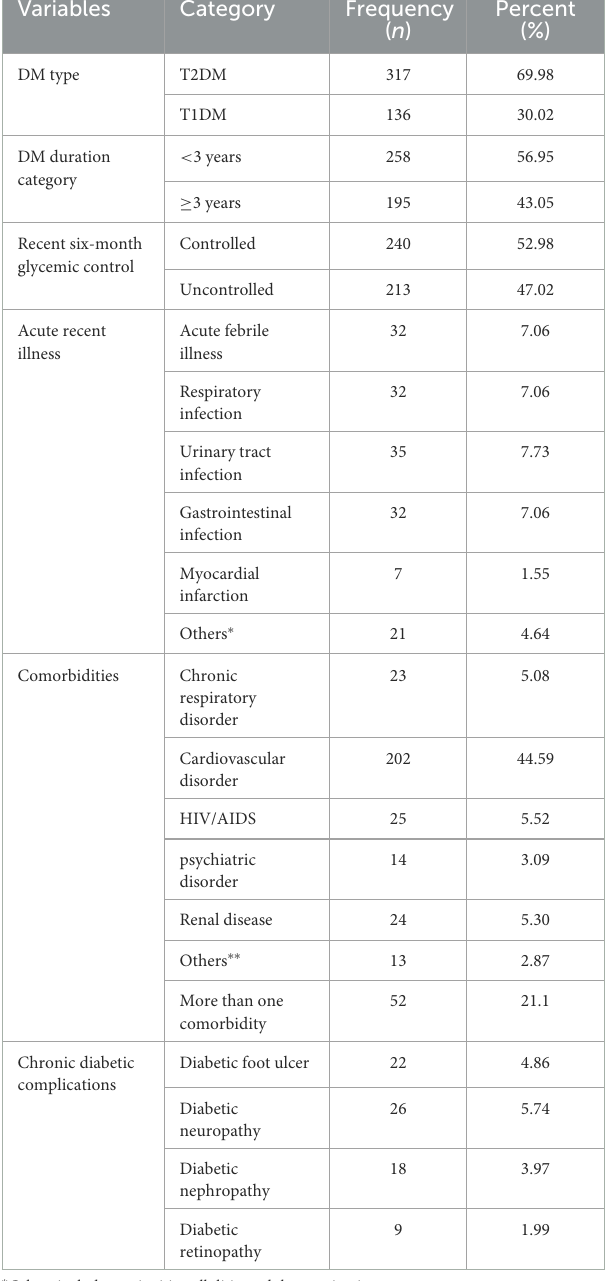
TABLE 1 Baseline socio-demographic results of adult patients with diabetes in Bahir Darpublic hospitals, North West Ethiopia, 2021( n = 453). Variables